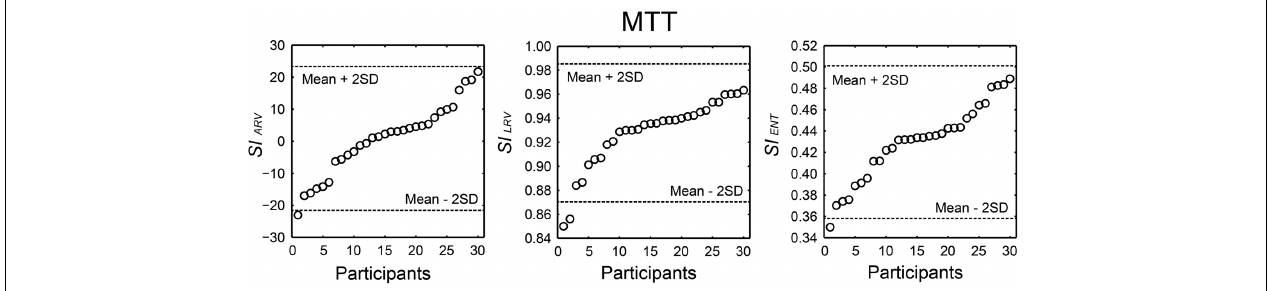
FIGURE 10 | Distribution of the synchronization indices ( SI s) calculated from angle of resultant vector ( SI ARV ), length of resultant vector ( SI LRV ), and entropy of relative phase distribution ( SI ENT ) obtained from 30